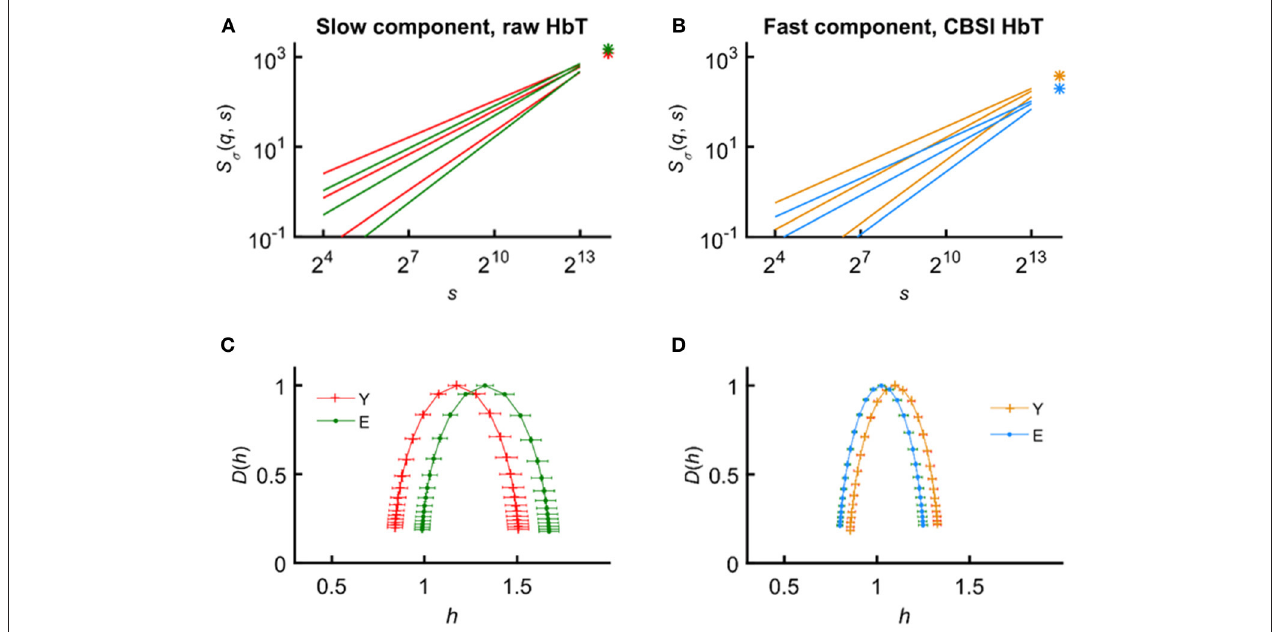
FIGURE 8 | Input and output parameters of the focus-based multifractal formalism in the young and elderly groups for the slow (vasogenic) and fast (neurogenic) components of CBV fluctuations. Average scaling functions (A,B) and average singularity spectra (C,D) obtained for the raw and CBSI-pretreated HbT signal. Age coding: young—red (A,C) , blue (C,D) ; elderly—green (A,C) , orange (B,D) . Preserved focus and increased correlation characterize the age-related changes of the vasogenic component (A) . Conversely, these parameters of the neurogenic component indicate a decline apparent in the average scaling functions (B) . The alteration of h max is a good indicator of the right-ward shift of D(h) for the vasogenic (C) and a left-ward shift for the neurogenic component (D) . It also reveals altered correlation properties if the shape and distribution of singular behavior is not much affected, which happens to be the case in this study as the distribution of Hölder exponents was found symmetrical around h max irrespective of age and